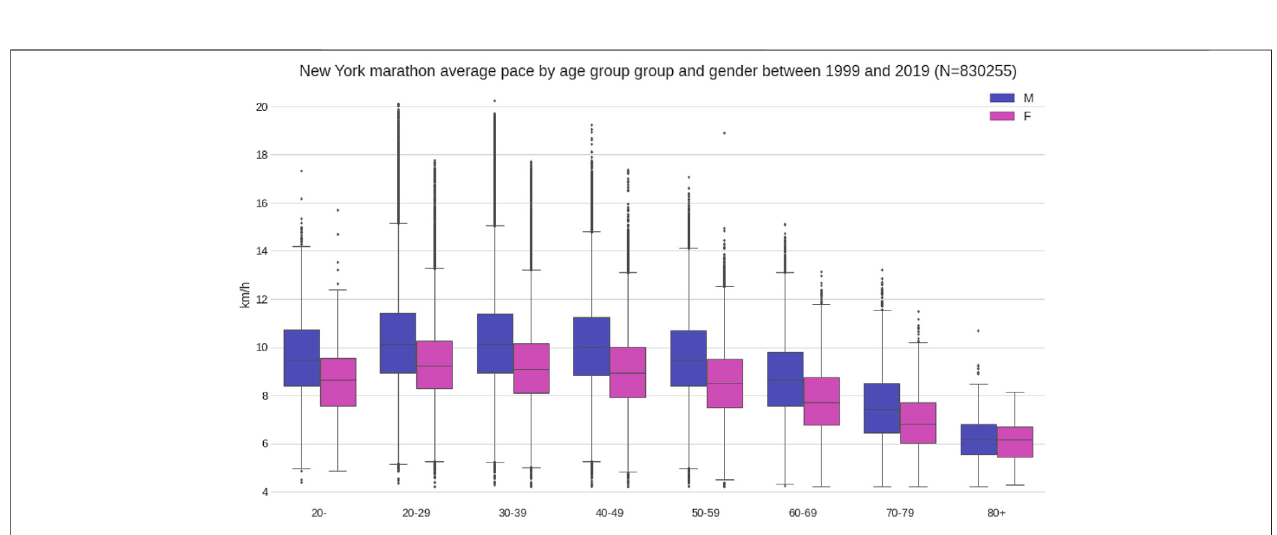
FIGURE 3 | Running speed by age group in